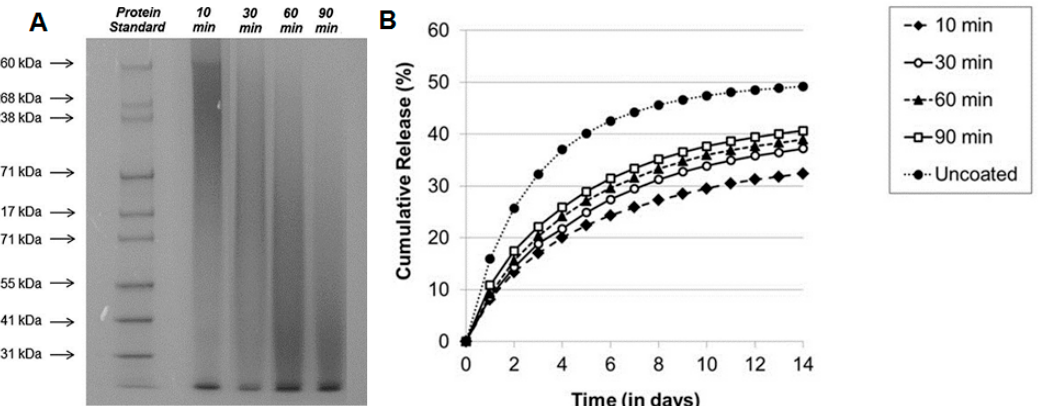
Figure 5. ( A ) SDS-PAGE analysis of silk with different degumming times (10 min, 30 min, 60 min and 90 min); ( B ) Cumulative release of rifampicin from silk gel films capped with a single layer of silk prepared using varied degumming times. (Reproduced with permission from Reference [27], John Wiley and Sons).